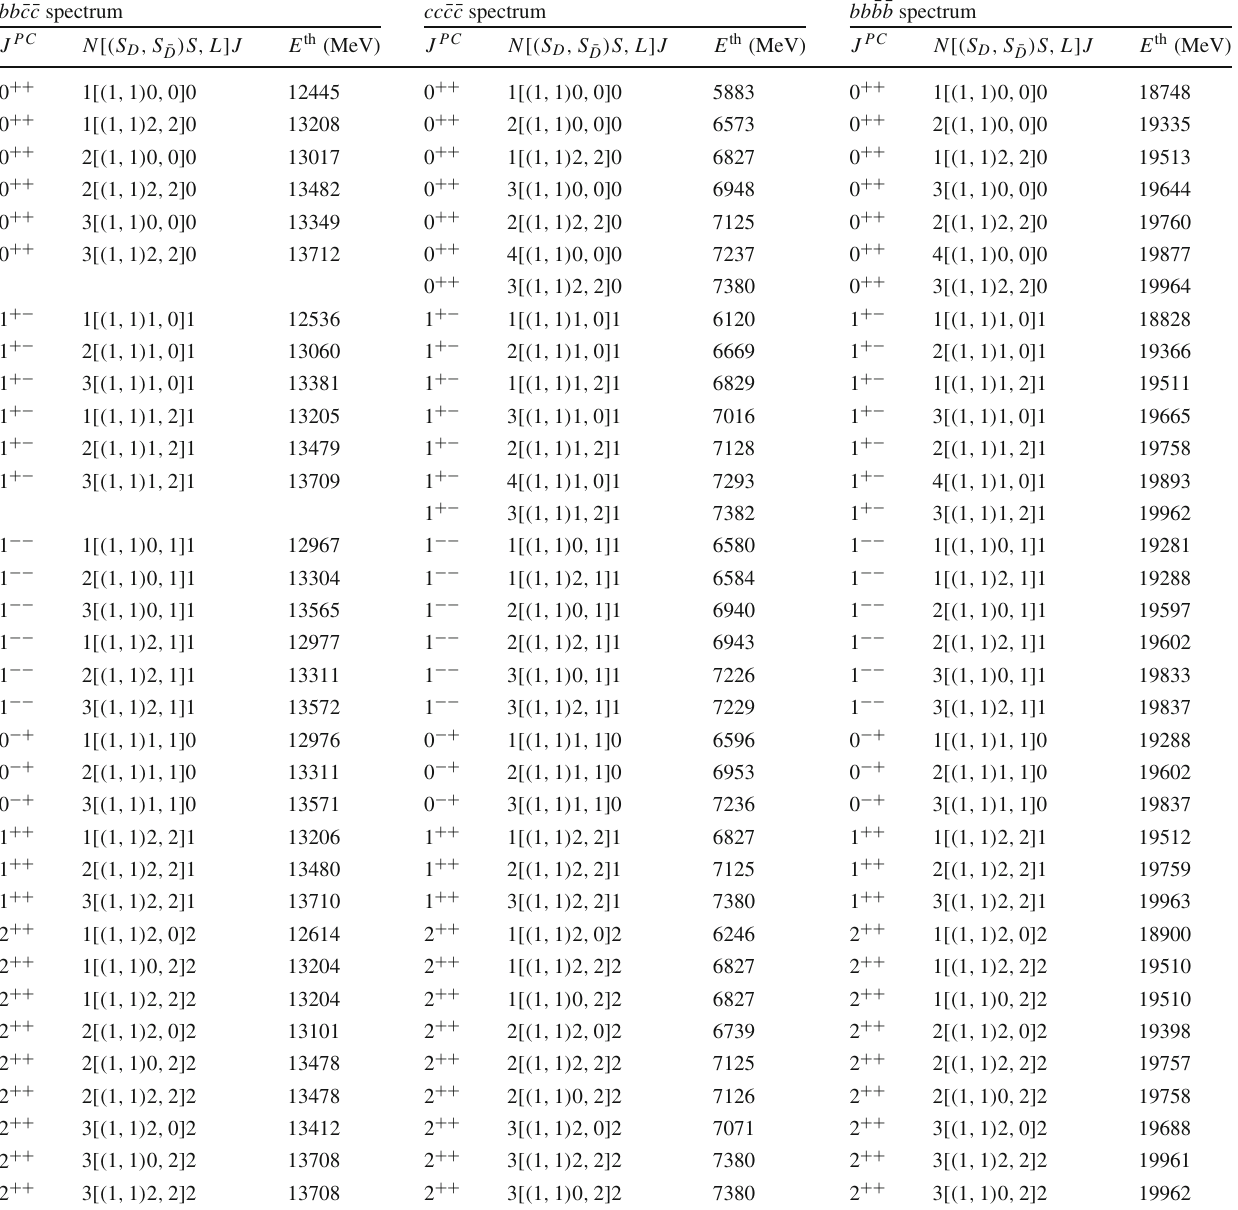
Table 3 Spectra obtained by solving the eigenvalue problem defined diquark and antidiquark, respectively, coupled to the total spin of the by Eq.(1). Following Sect. 3.3 (first procedure), the model uncertainty meson, S ; the latter is coupled to the orbital angular momentum, L , to in each result is (cid:2) 2%. The states are labelled thus: N is the radial get the total angular momentum of the tetraquark, J . Degenerate states quantum number ( N = 1 is the ground state); S D , S ¯ are the spin of the are orthogonal combinations of diquark+antidiquark spin vectors D